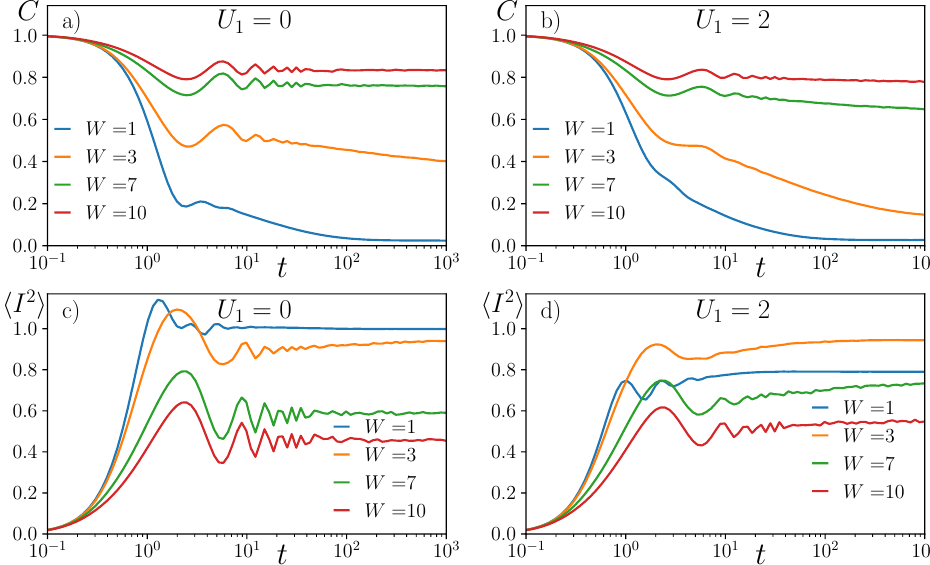
Figure 10: Time evolution of the correlation functions (top panels) and of 〈 I 2 ( t ) 〉 , = 0 (a),(c) corresponding to the intensity of the emitted light, (lower panels) for U 1 = 2 (b),(d), and for different values of W . The initial state of the upper and U 1 〉 . With increasing panels is a random Fock state, for the lower panels state | DW 2 disorder strength the correlations saturate to larger values in the MBL regime - that is associated with a decrease of 〈 I 2 〉 . The normalization of 〈 I 2 〉 is chosen so that it = 0. The data have been calculated saturates to unity at large times for W = 1 and U 1 K = 16 and averaged over 1000 disorder realizations (starting time evolution from different randomly chosen Fock state in calculation of C ( t )